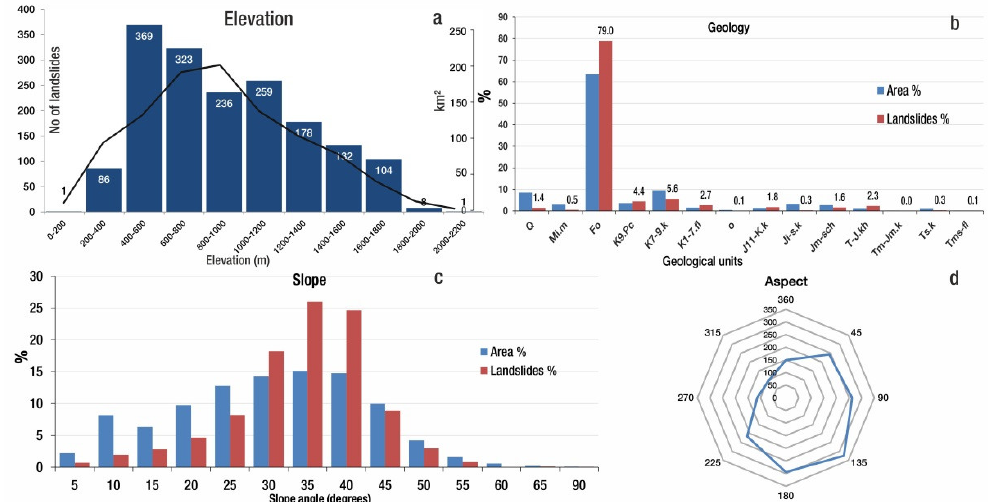
Figure 4. Statistical correlation of the spatial distribution of Ianos slope failures with: ( a ) elevation (histogram with area covered by each class in km 2 with a black line), ( b ) geology, ( c ) slope angles and ( d ) histogram of slope aspect values.